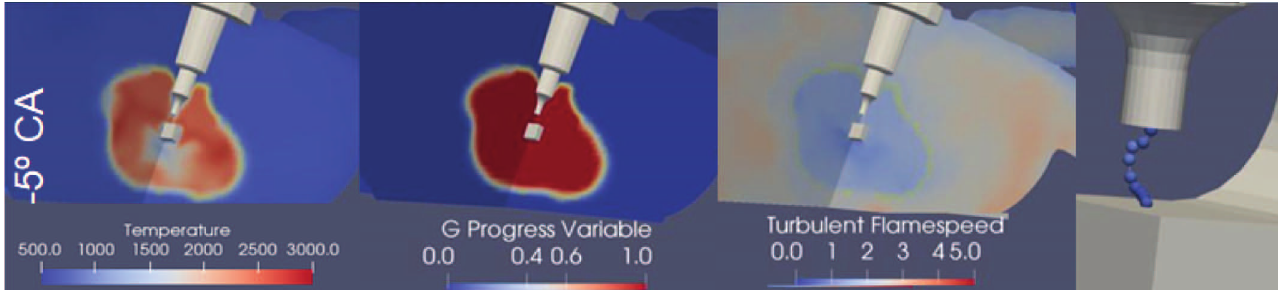
Fig. 16. g -eq model and LESI ignition model, from left to right: iso-contours of temperature, iso-contours of the g progress variable, iso-contours of the turbulent fl ame speed S t , and arc shape as predicted by LESI model at (cid:2) 5 (cid:3) CA aTDC.